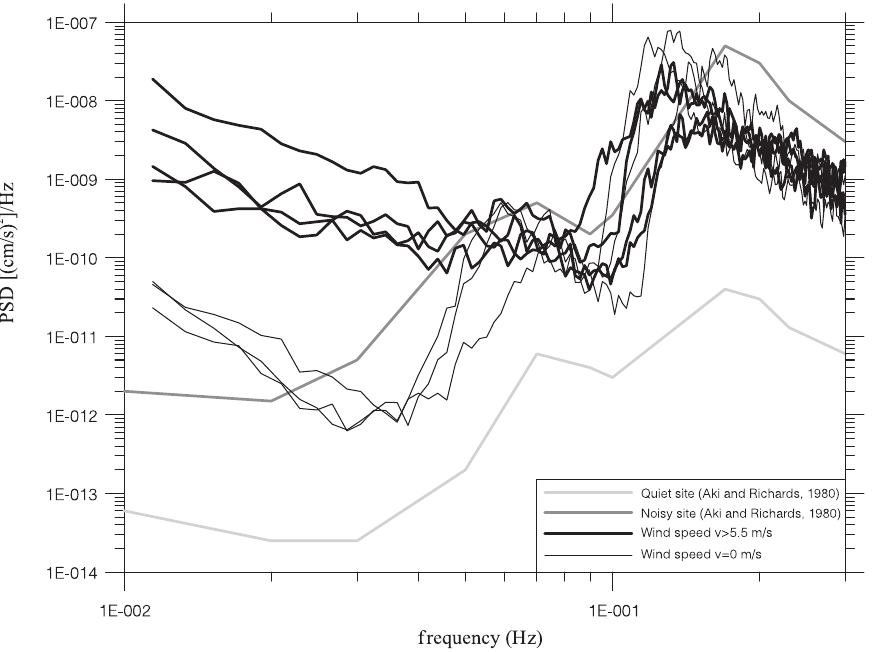
Fig. 4. Velocity power spectral density of the N-S component long period ambient seismic for wind and quiet meteorological conditions in